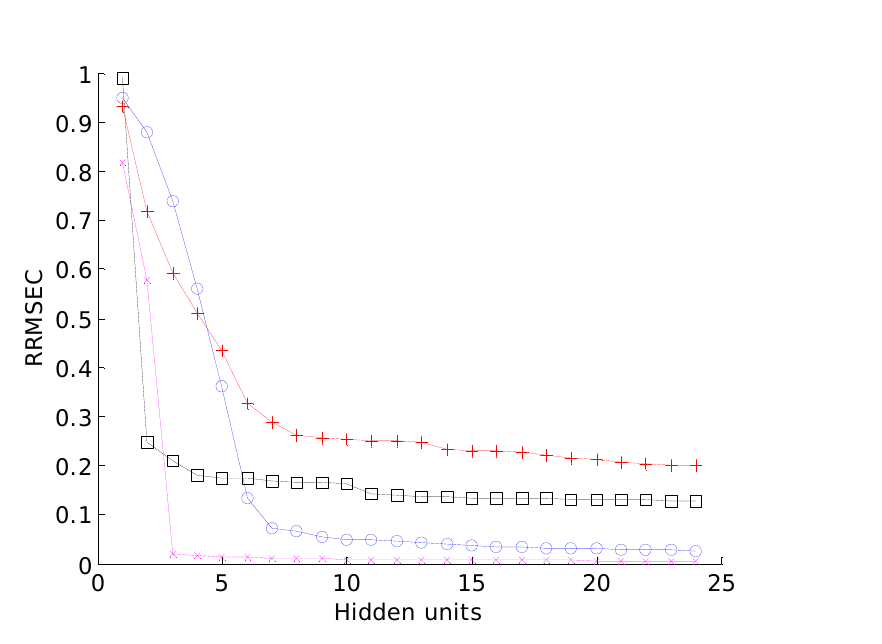
Figure 6. The RRMSEC with respect to hidden unit number trained by the RBFCCN using one training data set from the bootstrapped Latin partition. Magenta line with cross sign marker: novel class data set; black line with box marker: imbalanced data set; red line with plus sign marker: Italian olive oil data set; blue line with circle marker: PCB data